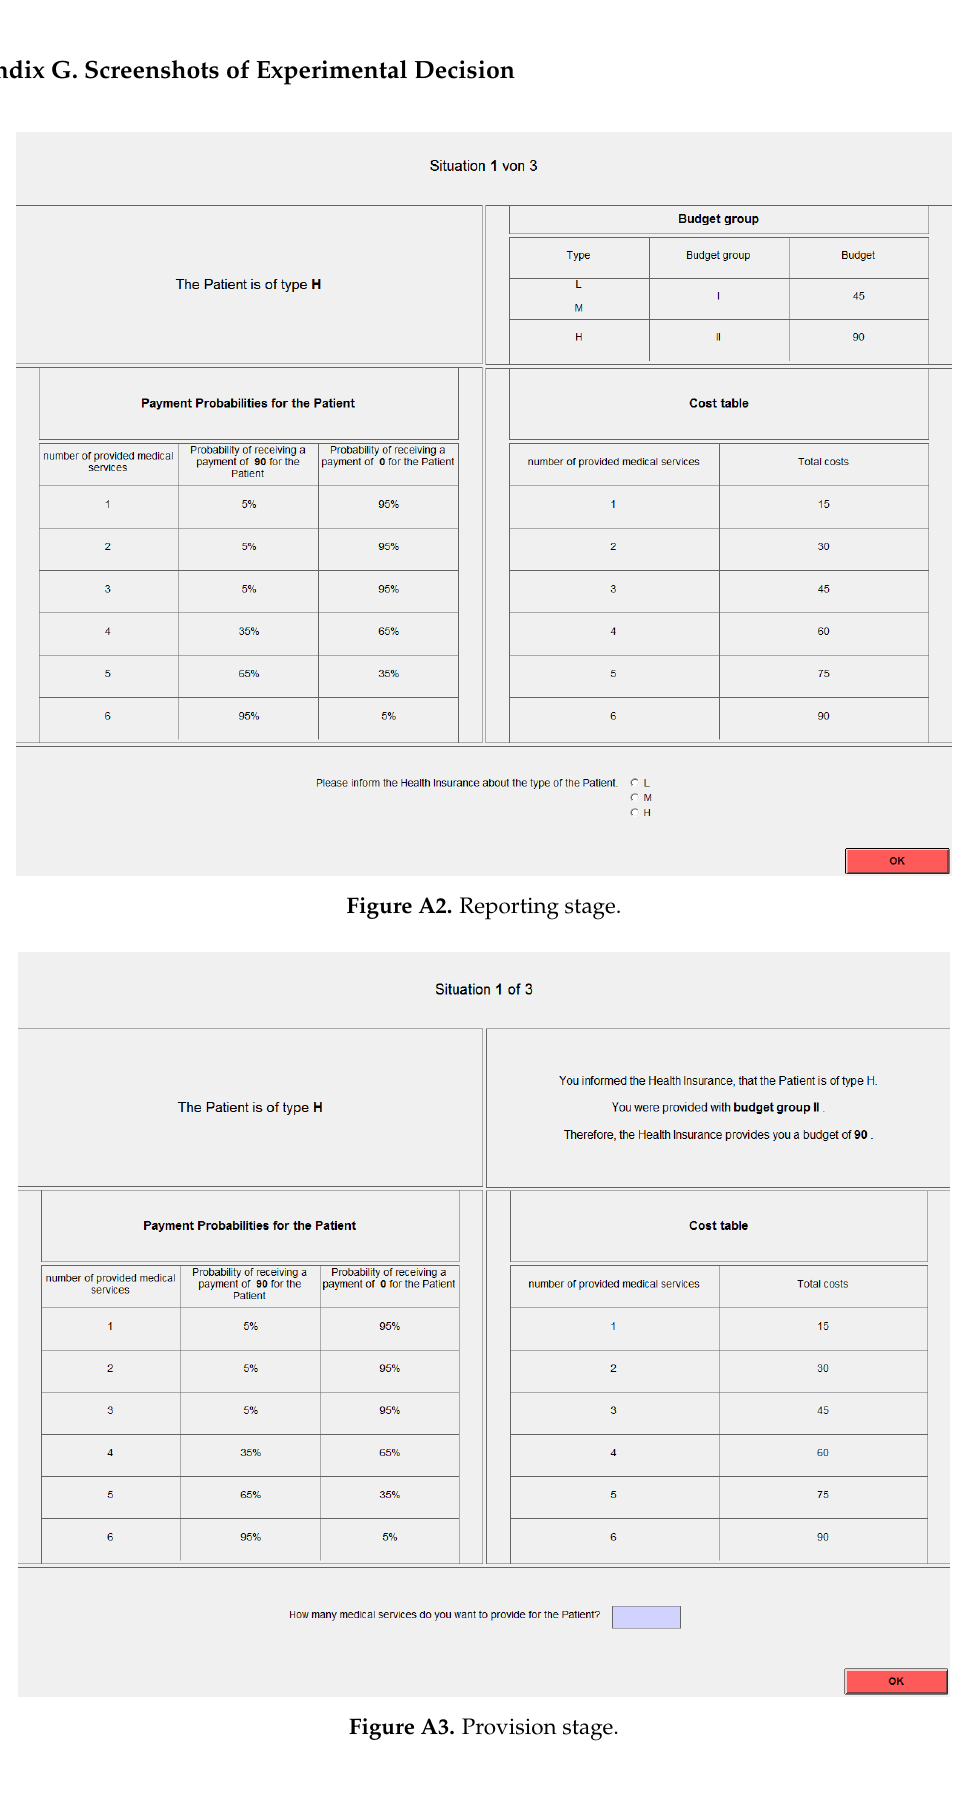
Figure A3. Provision